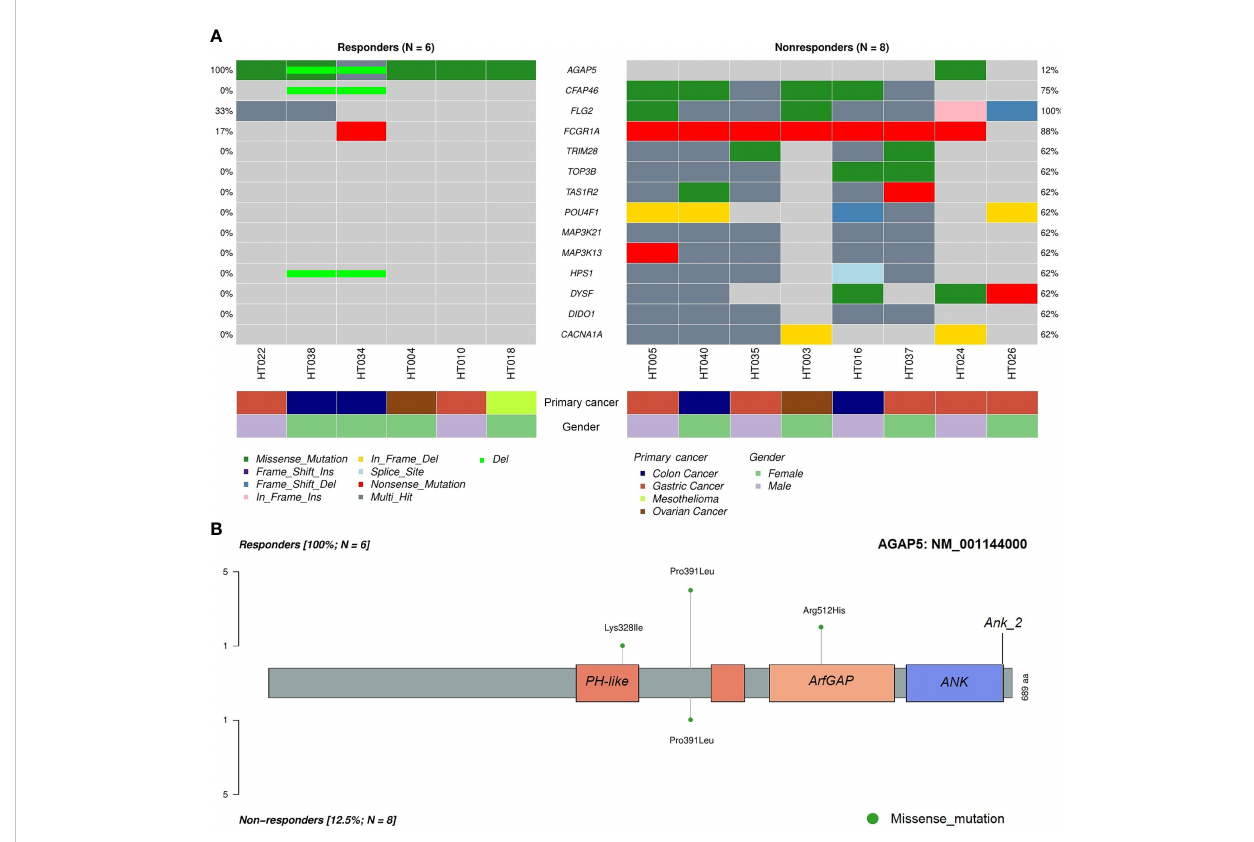
FIGURE 5 Differentially mutated genes in tumor samples between responders and non-responders. (A) Differentially mutated genes between the two cohorts with frequencies and classi fi cations of mutations. (B) Lollipop plot demonstrating mutated amino acids on different functional domains of AGAP5 . ANK, ankyrin repeat; PH, pleckstrin